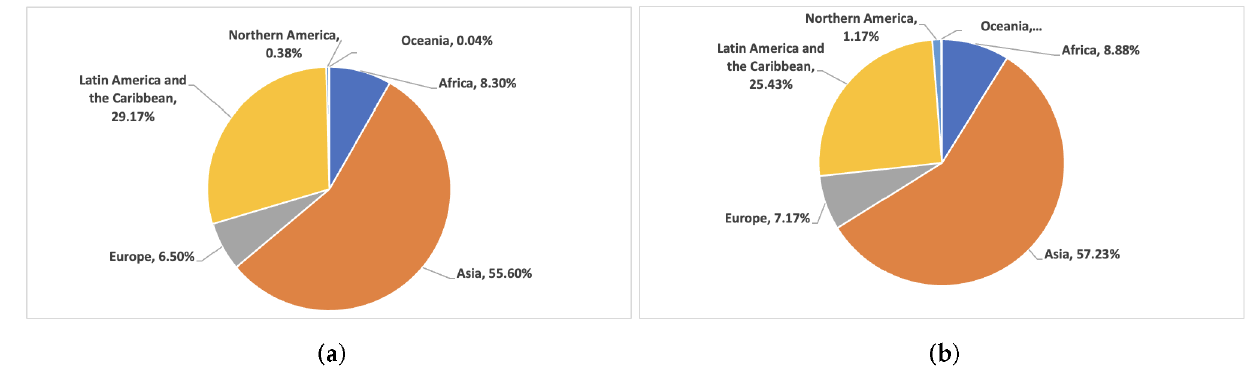
Figure 3. Statistics of the crowd-sourcing study participants’ demographics. ( a ) Statistics of the participants’ demographics in terms of the percentage of participants from different regions of the world. ( b ) Statistics of the participant demographics in terms of percentages of responses received from participants belonging to different regions of the